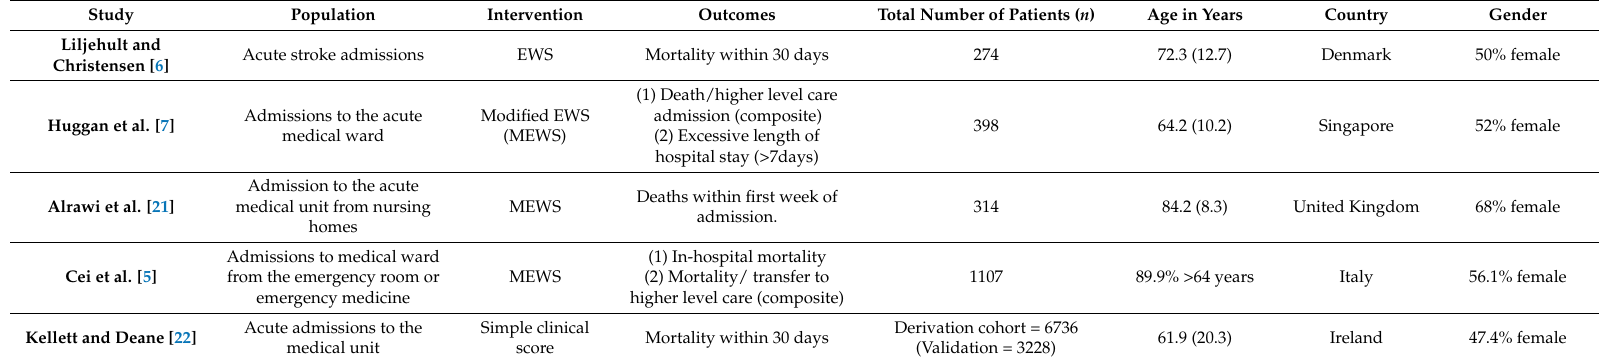
Table 2. Summary of study characteristics. EWS: early warning